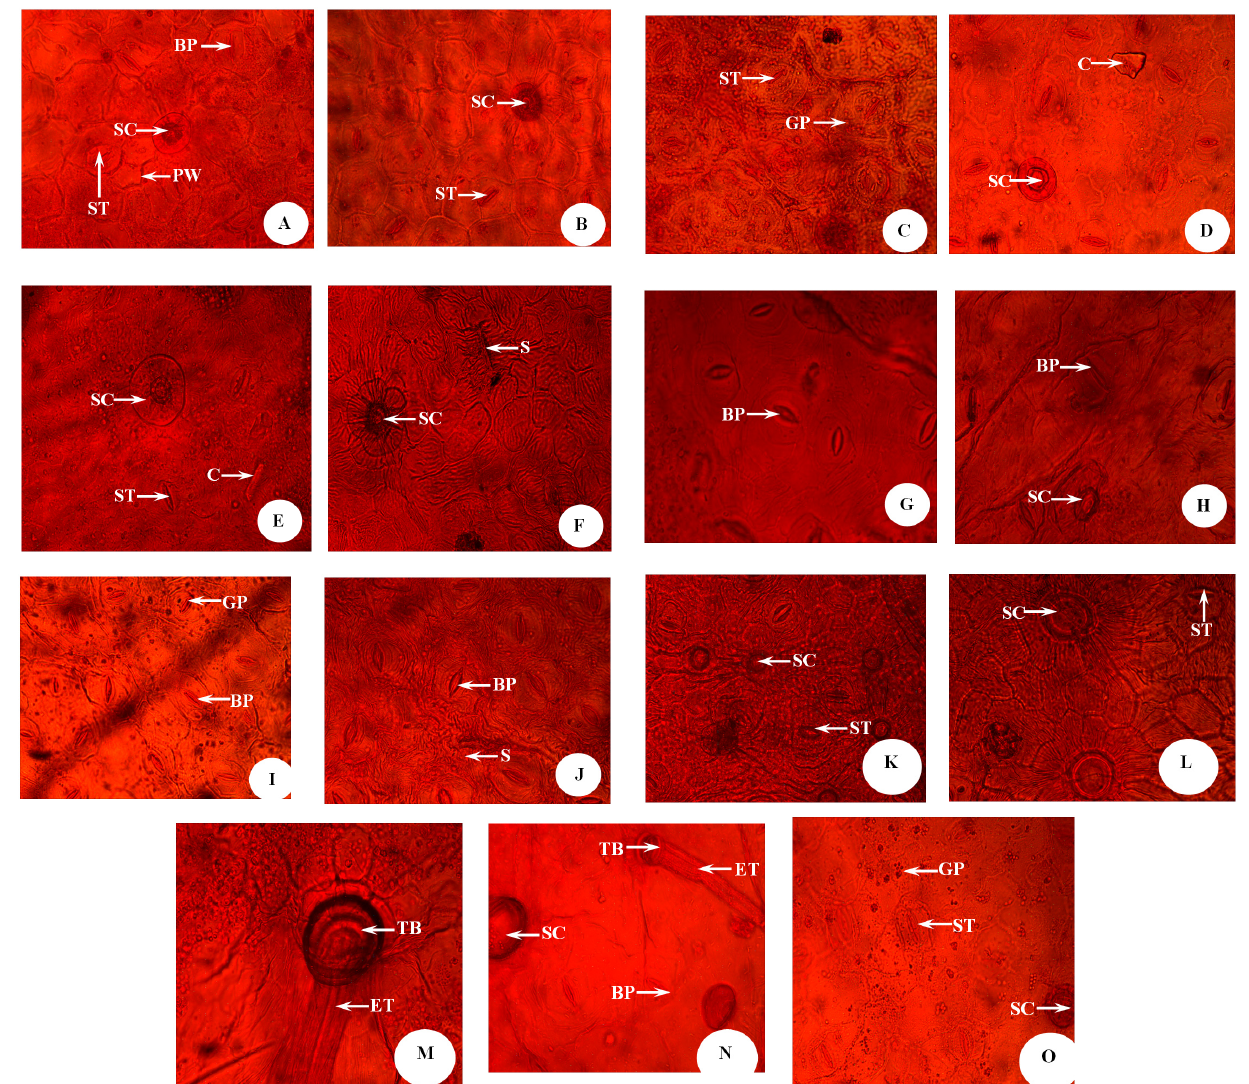
Fig. 1. Adaxial surface of Ipomoea species. A) I. triloba , B) I. eriocarpa , C) I. alba , D) I. hederifolia , E) I. muricata , F) I. intrapilosa , G) I. asarifolia , H) I. batatas , I) I. aquatica , J) I. mauritiana , K) I. carnea , L) I. involucrata , M) I. nil , N) I. heterotricha , O) I. obscura .; BP = Brachyparacytic stoma, SC = Scale, PW = Periclinal wall, ST = Stoma, GP = Granular periclinal wall, C = Crystal, S = Striae, TB = Trichome base, ET = Eglandular trichome, Scale = 0.85